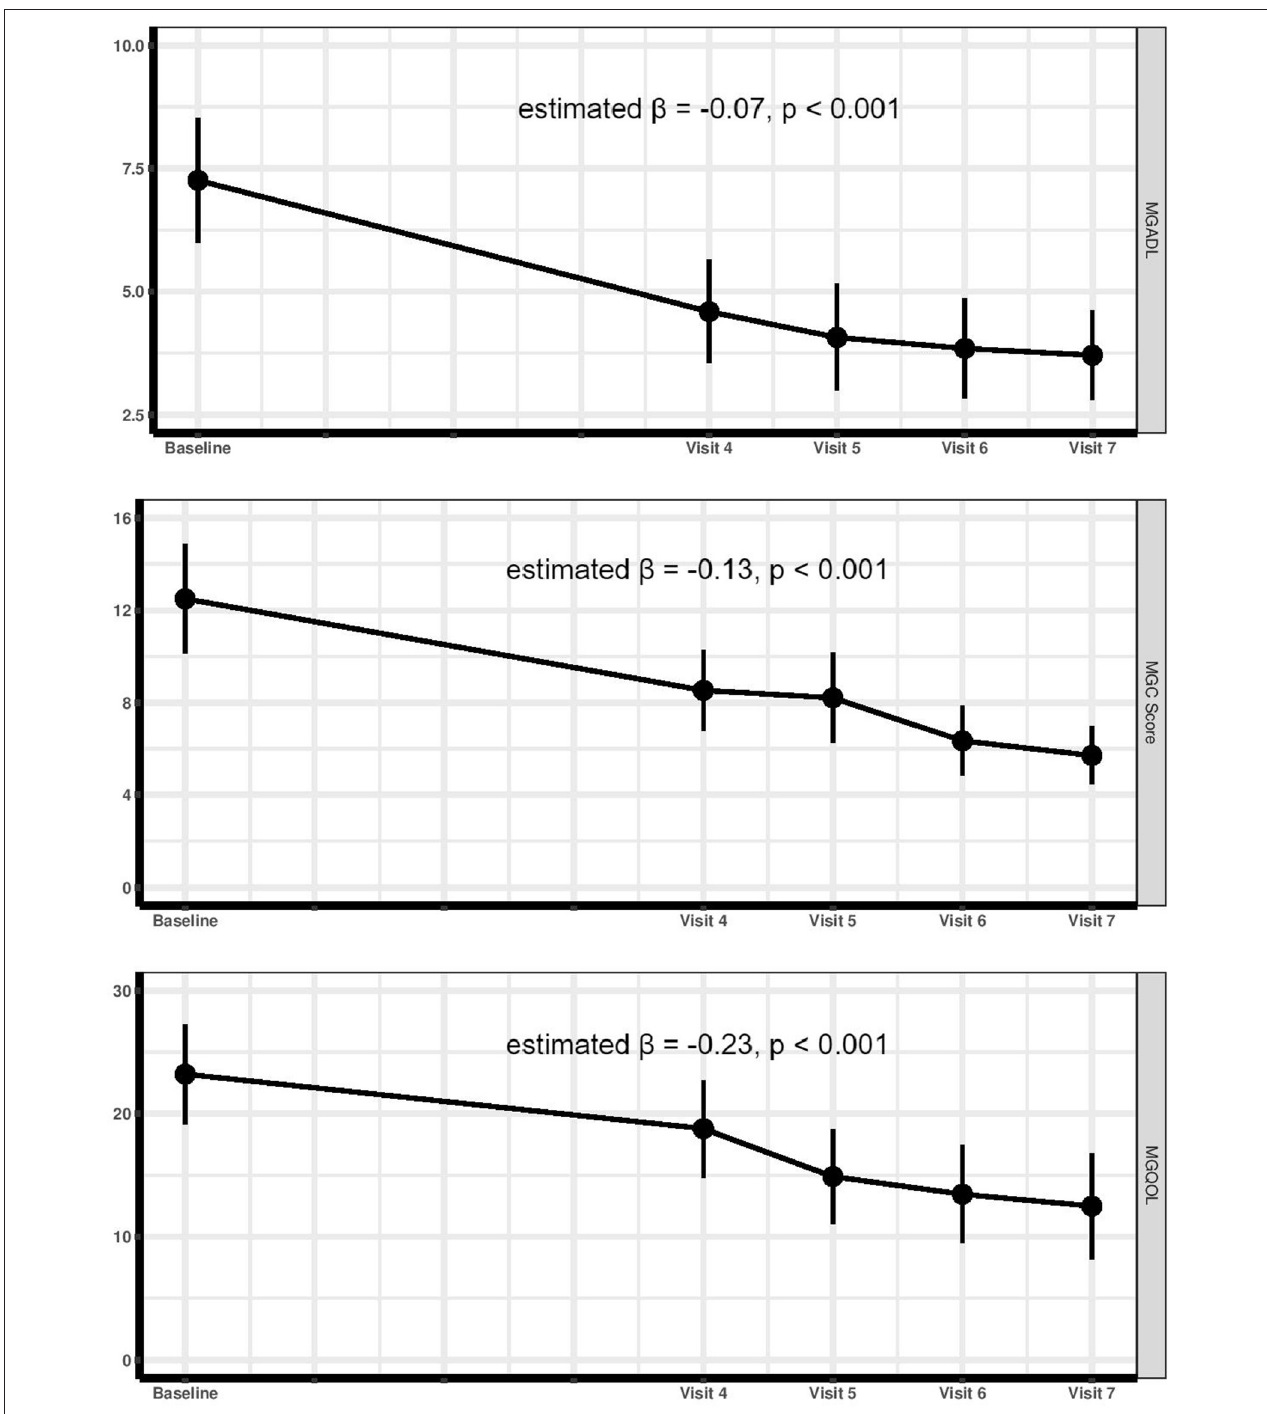
FIGURE 2 | Generalized estimating equations for analyzing the alteration trend of Myasthenia Gravis Activities of Daily Living (MG-ADL), Myasthenia Gravis Composite scale (MGC), and MG Quality of Life Questionnaire (MG-QoL15) scores during the trial period.